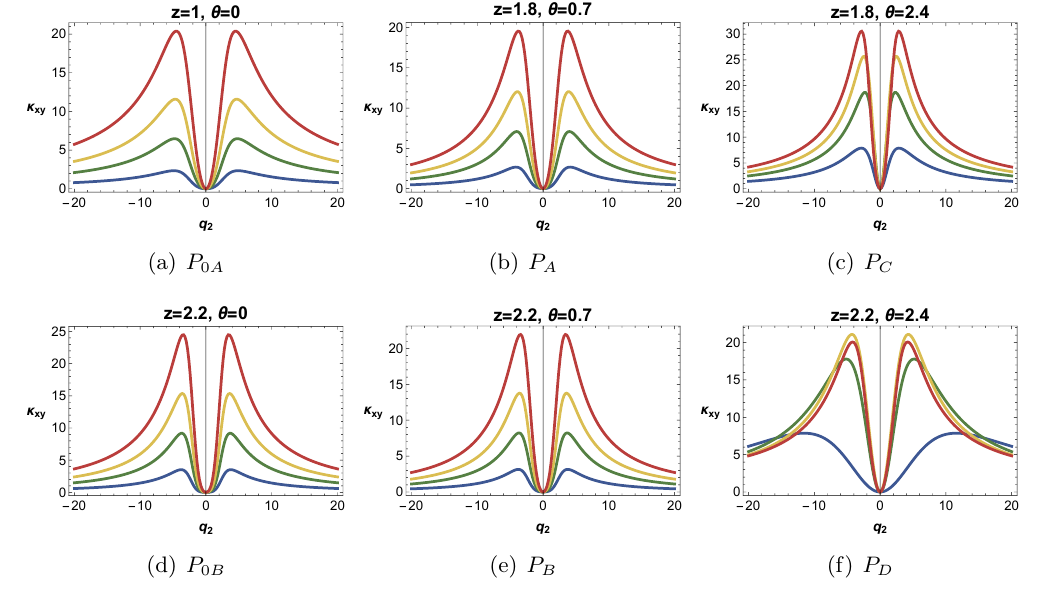
Figure 24 . Temperature evolution for (cid:20) xy ( q 2 ) for di(cid:11)erent ( z; (cid:18) ). Each curves corresponds to T = 0 : 04 ; 0 : 1 ; 0 : 16 ; 0 : 24 for blue, green, yellow, and red respectively. We used q (cid:31) =